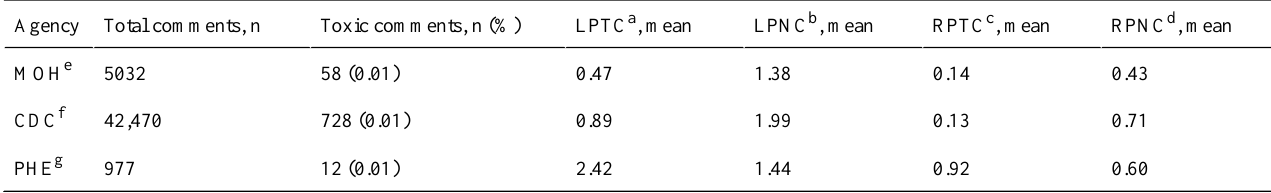
Table 5. Summary of coronavirus disease toxic